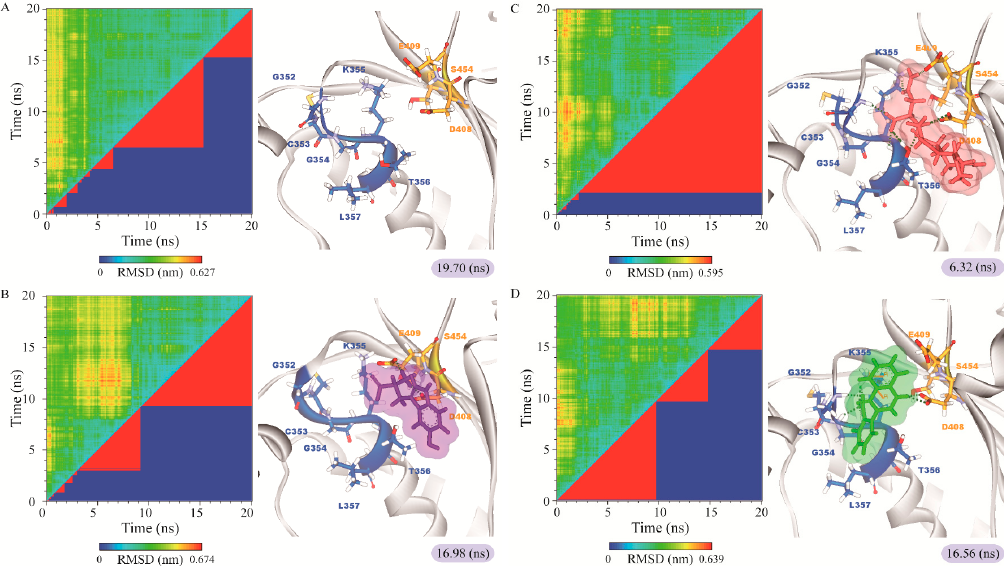
Figure 10. Cont. Figure 10. RMSD matrix and clustering diagram of MD comformations with the middle RMSD structure in the major cluster for ( A ) apo form of paraplegin protein and paraplegin complexes with ( B ) 5-hydroxy- L -tryptophan; ( C ) saussureamine C; and ( D ) 3-(2-carboxyphenyl)-4(3H)-quinazolinone and the correlation between each complex.